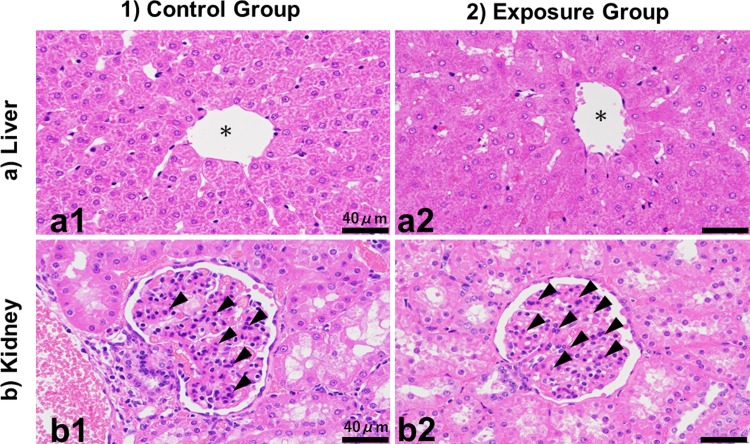
Results of histopathological examination.1) Control group, 2) Exposure group. a) Sections of area around the central vein in liver. * shows a central vein, b): Sections of glomerulus in kidney. Arrows show mesangial cells and area., a2: Livers in exposure group have slightly low levels of glycogen granules compared to those in control group (a1). b1: and b2: Mesangial cells in glomerulus slightly increased in both control group and exposure group. Magnification x 400.